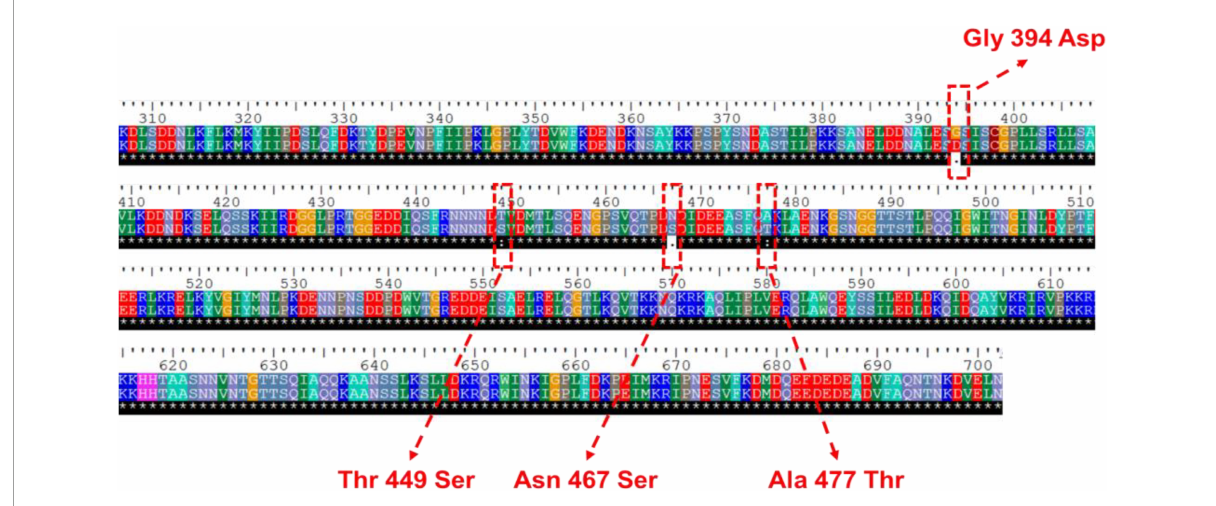
FIGURE1 Variations in amino acid sequence of Ngg1p in S. cerevisiae YB-2625 compared to S. cerevisiae